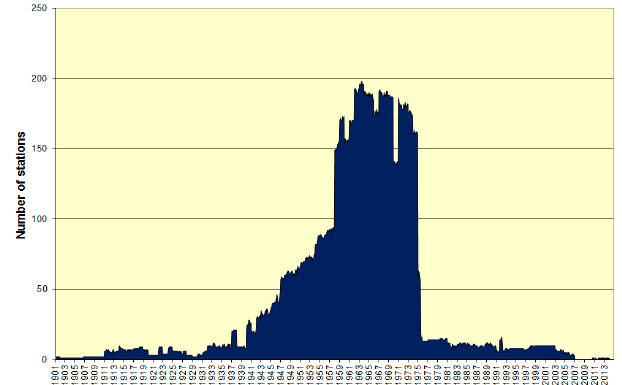
Figure 2. Number of stations with monthly precipitation data from Angola available in the database of Global Precipitation Climatol- ogy Center (GPCC) from 1901 to 2014 (status: 2014). Those sta- tions were used for the GPCC Full Data Product (Schneider et al., 2014). GPCC is hosted at